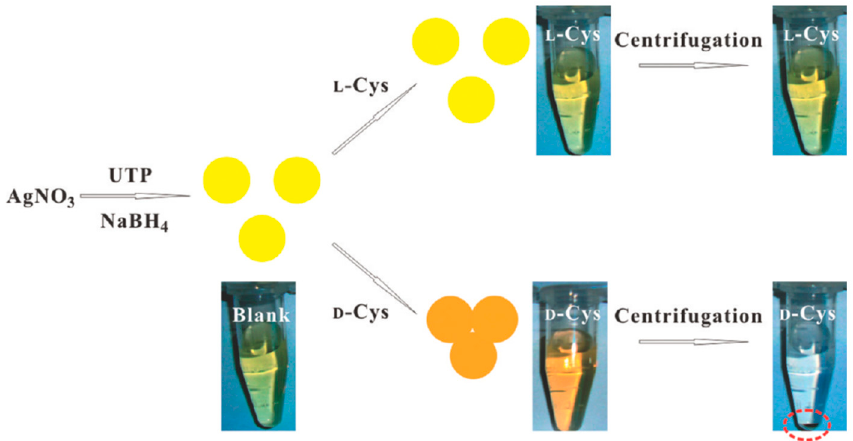
Figure 6. Colorimetric Discrimination of L - and D -Cys Using UTP-Capped AgNPs. The figure and the caption have been adapted with permission from [52], Copyright © 2011 American Chemical Society.